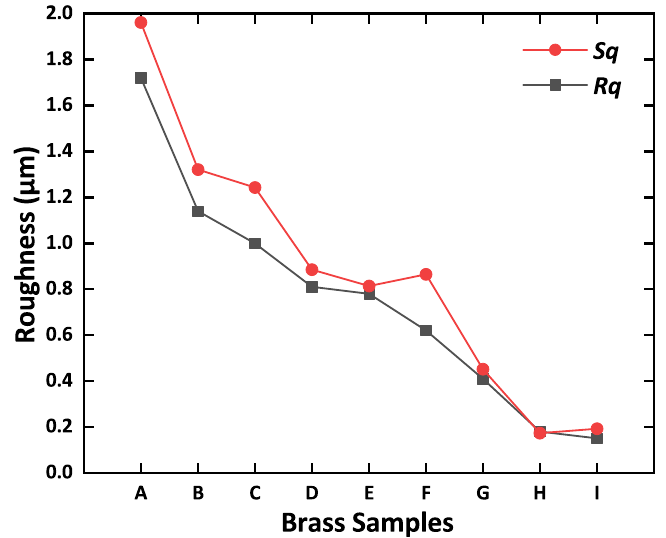
Figure 4. Comparison of Sq and Rq roughness values of brass samples, which were obtained by using WLI and roughness meter, respectively.